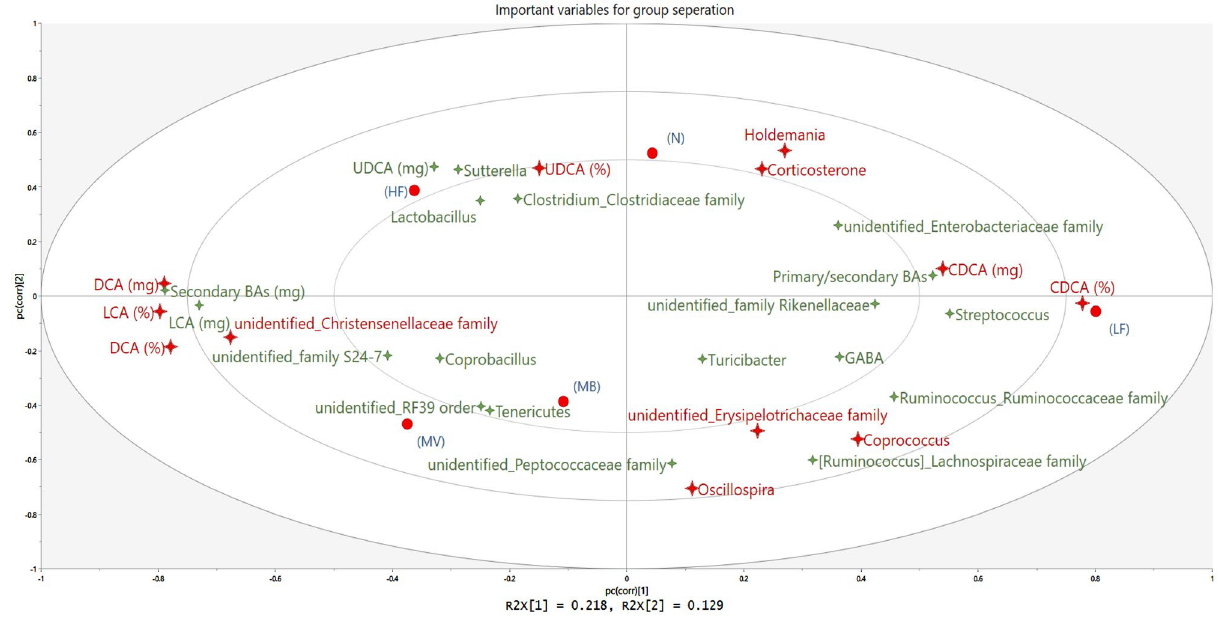
Figure 4. Important variables contributing to group separation. Conventional rats (N) fed a high-fat diet or ApoE-/- rats fed either a low-fat diet (LF), a high-fat diet as it is (HF) or supplemented with 1% monobutyrin (MB) or monovalerin (MV). Groups are shown as red circles, bacteria as 4-point stars. Large red stars are top important variables influencing group separation. Cholic acid (CA), chenodeoxycholic acid (CDCA), deoxycholic acid (DCA), gamma-aminobutyric acid (GABA), lithocholic acid (LCA), ursodeoxycholic acid (UDCA), α-muricholic acid (α-MCA) and β-muricholic acid